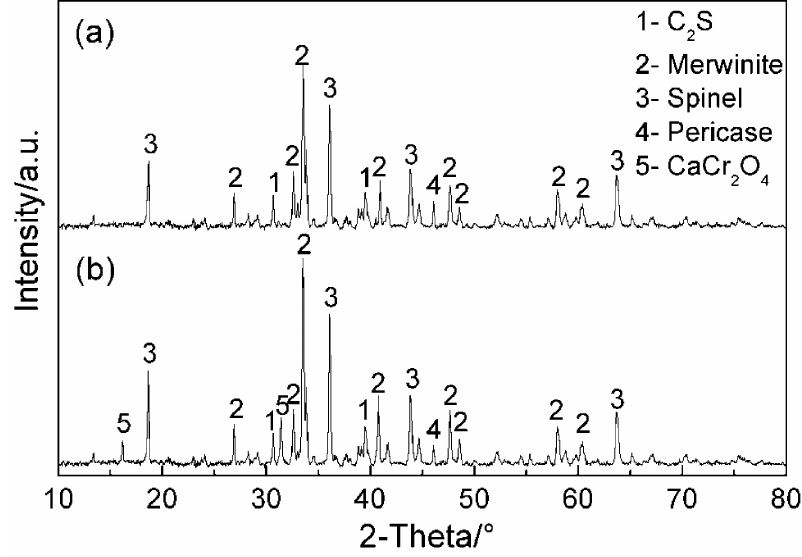
Figure 6. XRD patterns of ( a ) S4 and ( b ) S2 treated by a CaO lump.